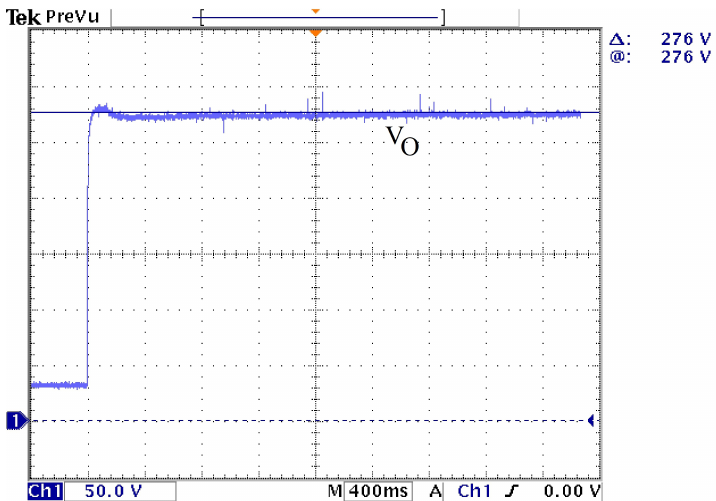
Figure 6. Output voltage vs. time.